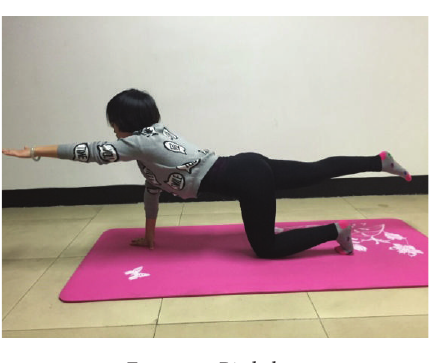
Figure 5: Bird-dog. Table 2: Relationship between muscle fatigue and rehabilitation exercise.